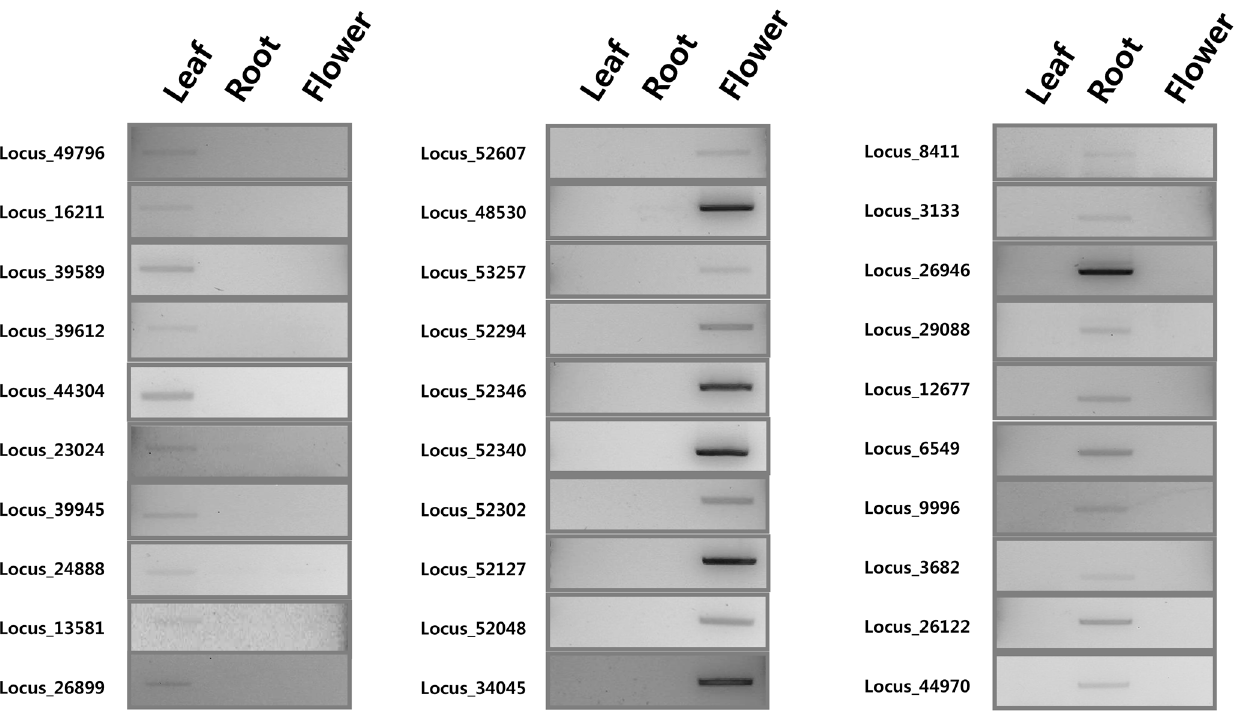
Figure 6. RT-PCR of tissue-specific cabbage genes. RT-PCR was performed with leaf and root samples of cultivar 107140 and the flower sample of cultivar 102043. The RT-PCR results of the leaf-specific (A), flower-specific (B) and root-specific (C) candidate loci are shown.